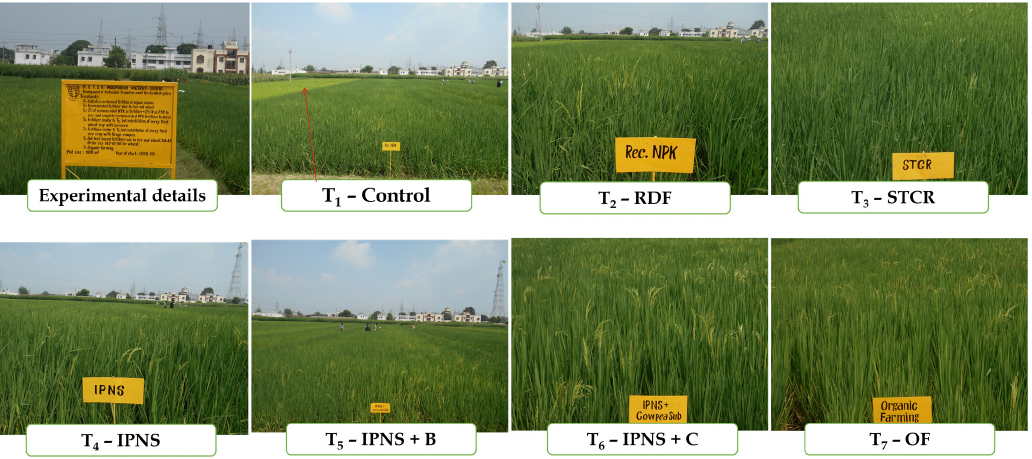
Figure 2. Experimental view during the Kharif season (rice) sowing all treatment